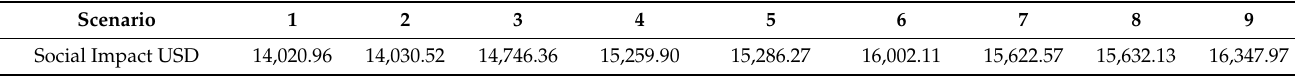
Table 8. Community social